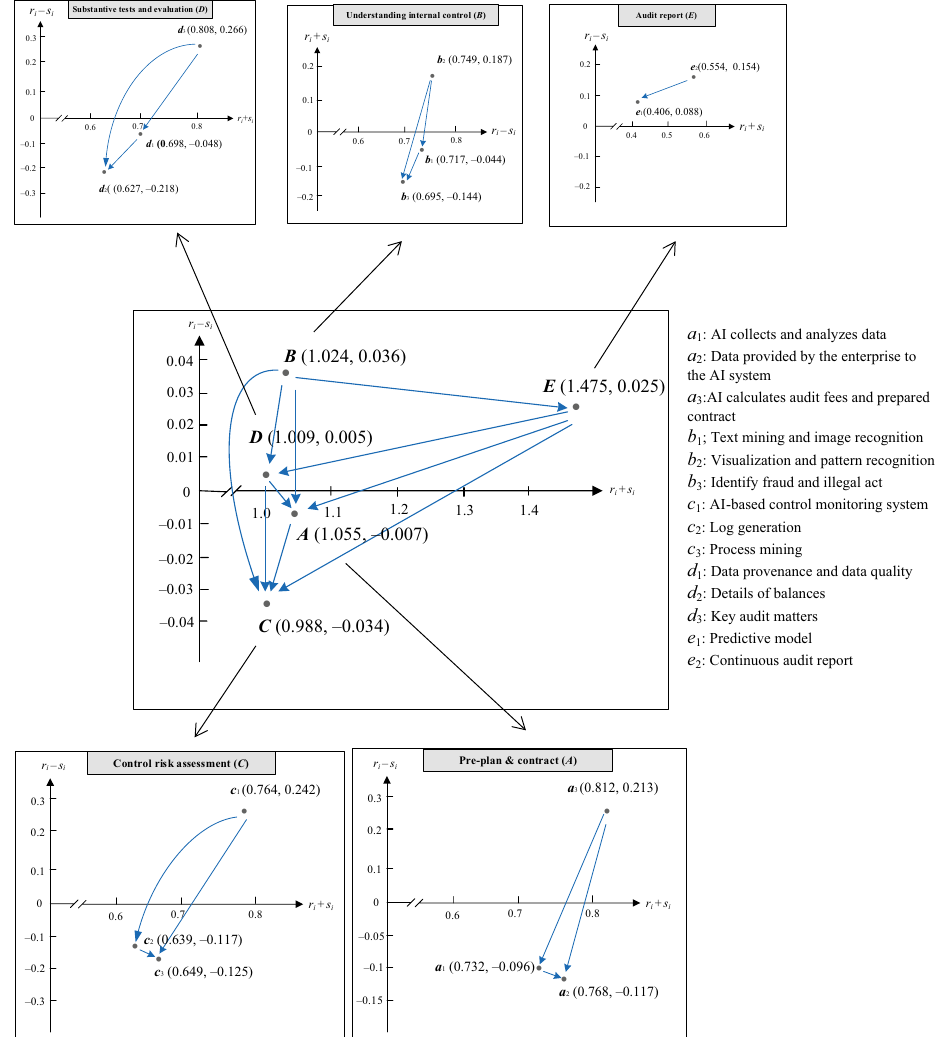
Figure 5. The IINRM of influence relationships based on DEMATEL within AI-enabled auditing adoption Using Eqs (A.5) and (A.6) (Stage 2 in Appendix A), the total influence relationship matrix q T for the criteria are obtained. Using Eq. (A.7), T and the normalized total influence matrix C C the unweighted super-matrix W is estimated by transposing the normalized total matrix T q . q T for the dimen- Total influence relationship matrix T and the normalized total matrix D D sions are demonstrated using Eqs (A.8) and (A.9). Next, the weighted super-matrix W q can be derived through Eq. (A.10). Subsequently, through self-multiplication of the super-weight- ed matrix among the criteria, the infinite power of the limit is taken until it converges and emerges as a long-term stable pattern (Table 6), which is the D-ANP influential